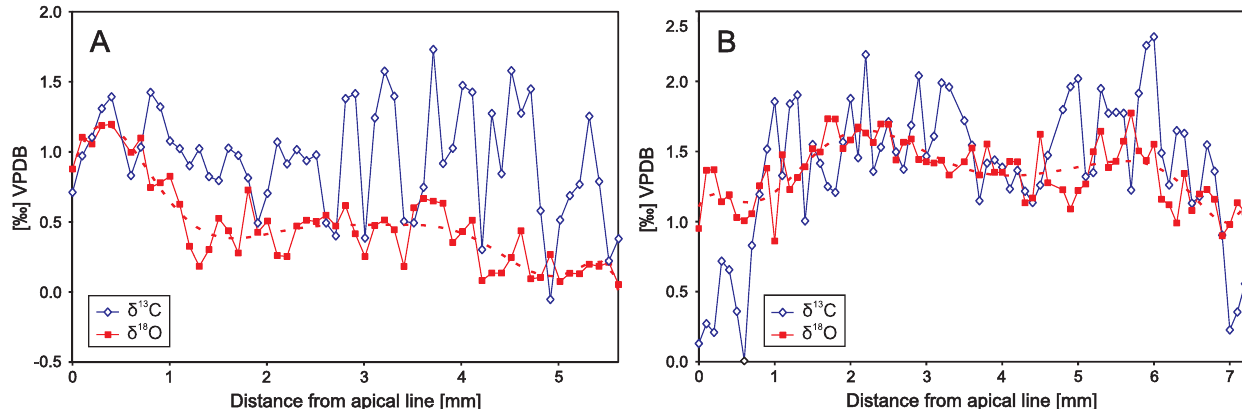
Figure 13. Ontogenetic δ 18 O trends throughout the Lower Bathonian (Middle Jurassic) belemnite rostra: ( A ) Hibolithes beyrichi and ( B ) Hibolithes hastatus from central Poland. Average δ 18 O trends are shown (reproduced with permission from Wierzbowski and Joachimski [322] “Stable isotopes, elemental distribution, and growth rings of belemnopsid belemnite rostra: proxies for belemnite life habitat”. Palaios, 2009, v. 24, p. 377–386. Copyright SEPM